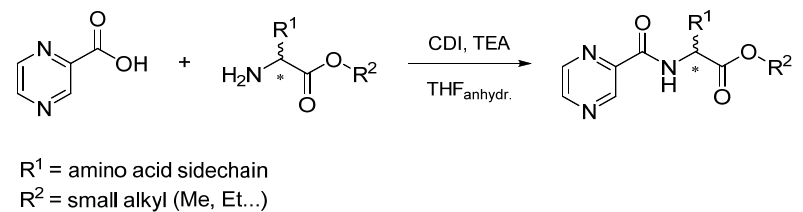
Figure 2. Schematic representation of Procedure 5. Asterisk symbol (*) denotes position of the stereo center. TEA—triethylamine.